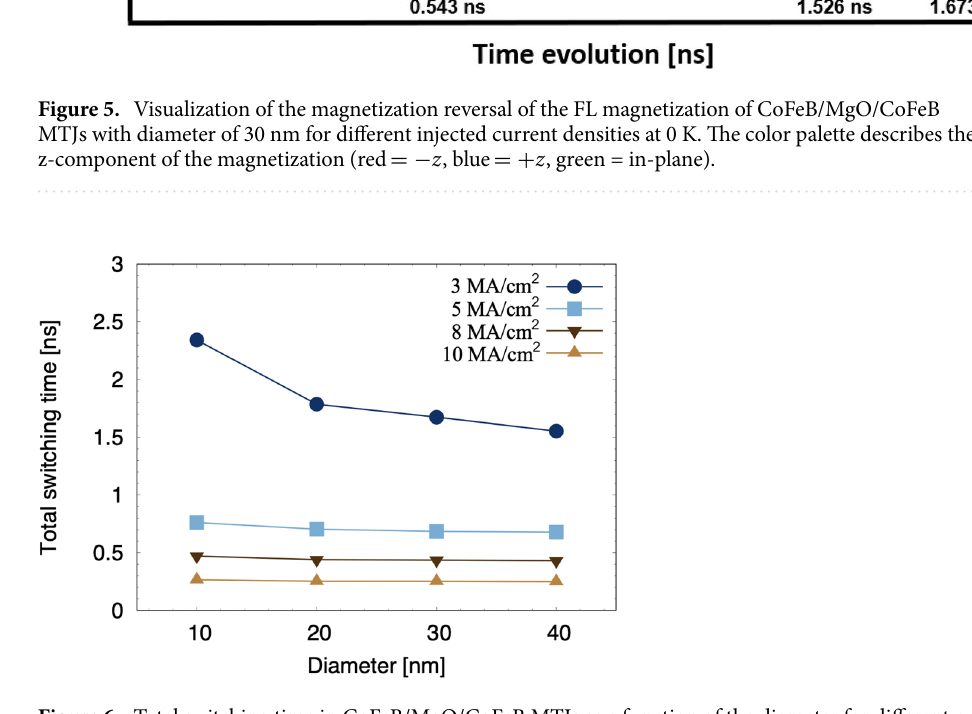
Figure 6. Total switching time in CoFeB/MgO/CoFeB MTJs as a function of the diameter for different current densities at 0